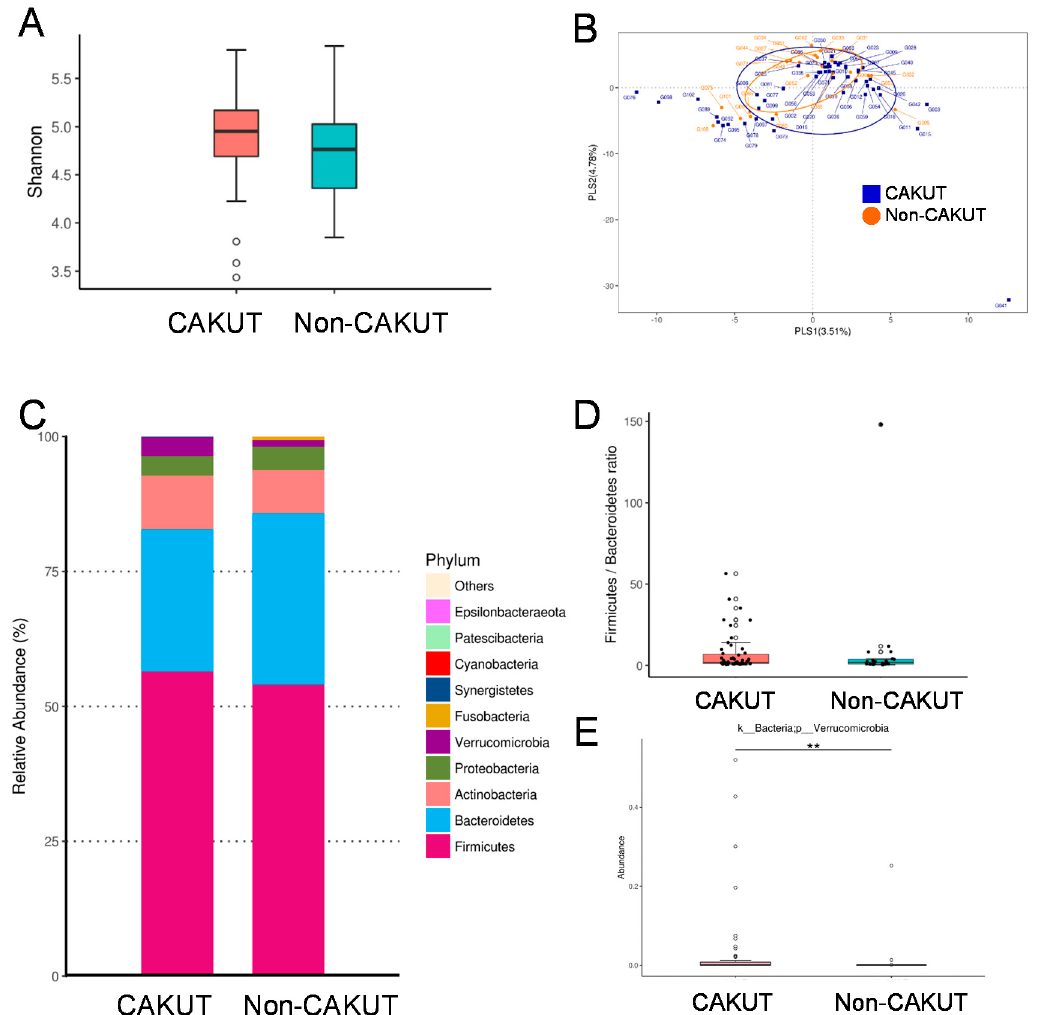
Figure 1. ( A ) Variation in fecal bacterial α -diversity analyzed by the Shannon’s diversity indexes. ( B ) β -diversity changes in gut microbiota across groups by the Partial Least Squares Discriminant Analysis (PLS-DA). ( C ) Relative abundance of the top 10 phylum of the gut microbiota between the CAKUT and non-CAKUT group. ( D ) Ratio of Firmicutes to Bacteroidetes (F / B), as a marker of gut dysbiosis. ( E ) The abundance of phylum Verrucomicrobia in CKD children with CAKUT vs. non-CAKUT. The double asterisk indicates p < 0.01.